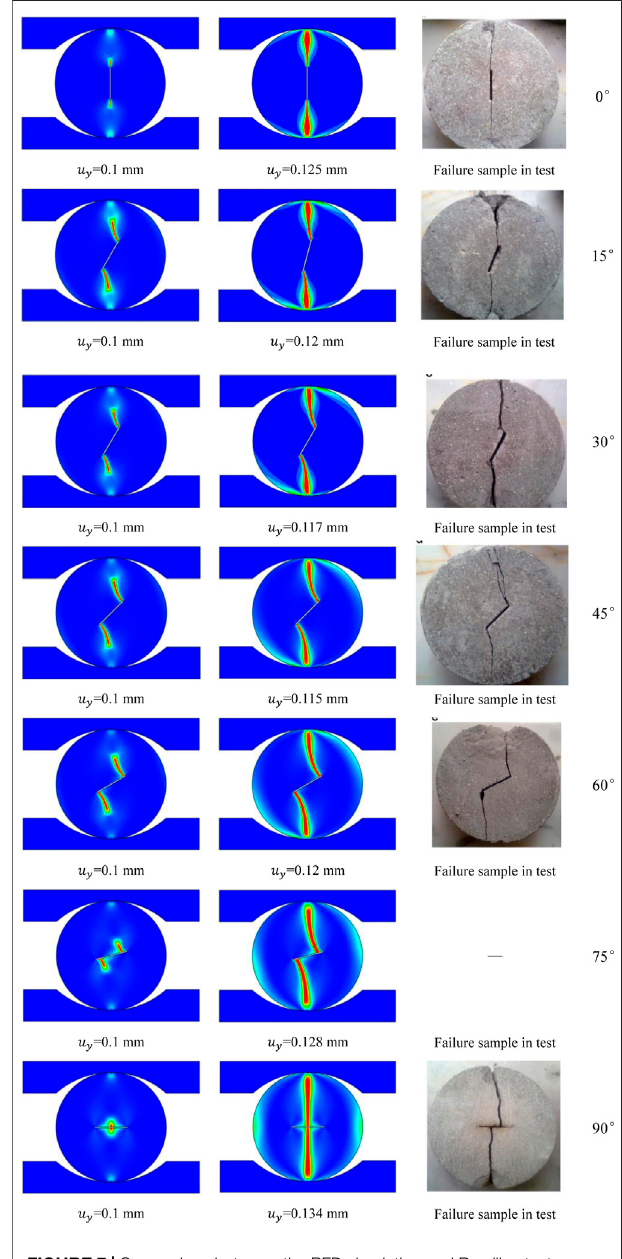
FIGURE 7 | Comparison between the PFD simulation and Brazilian test of disk samples with different inclination angles (test sample failure can be referred to [29]).